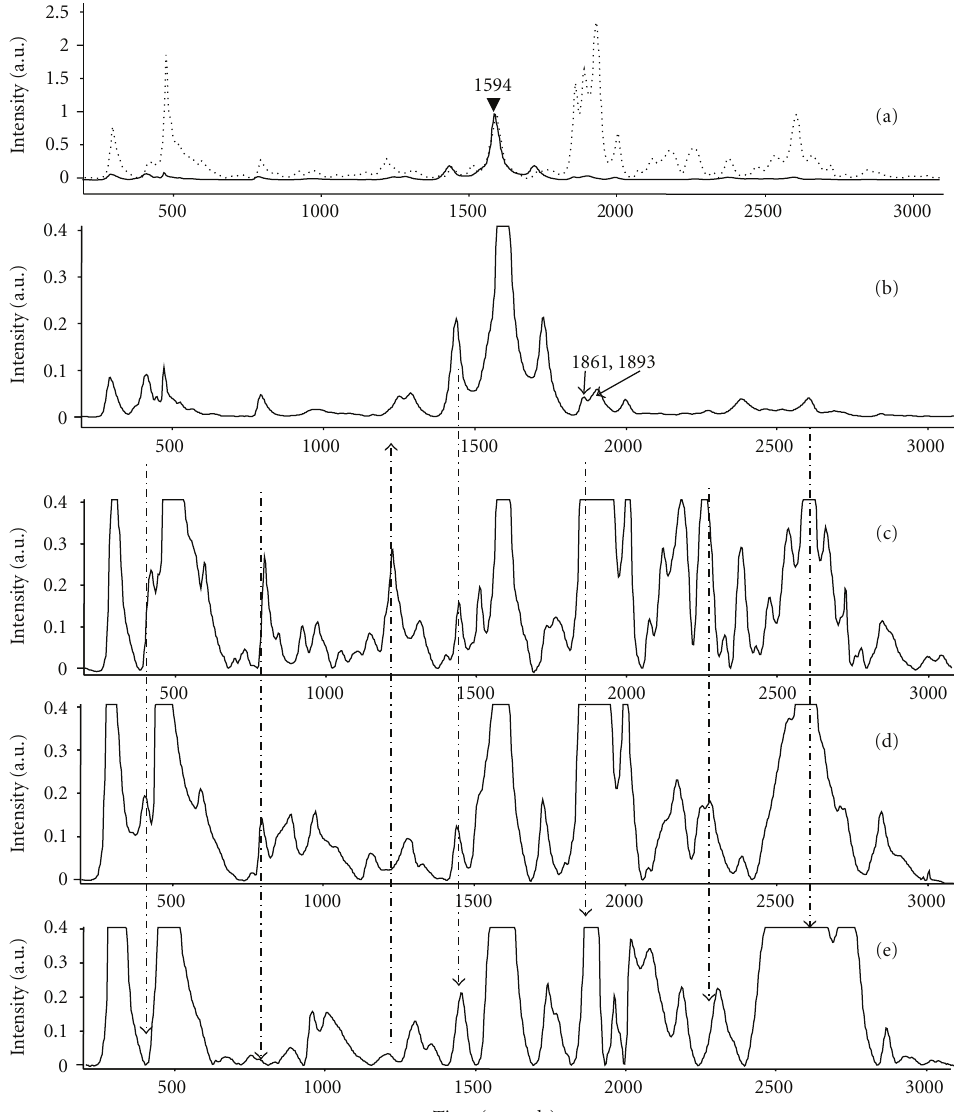
Figure 2: Mean protein profiles of cervical tissue homogenates: (a) normal (solid) and malignant (dotted); (b–e) expanded scale of protein profiles of tissue samples: (b) normal, (c) Stage II, (d) Stage III, and (e) Stage IV.